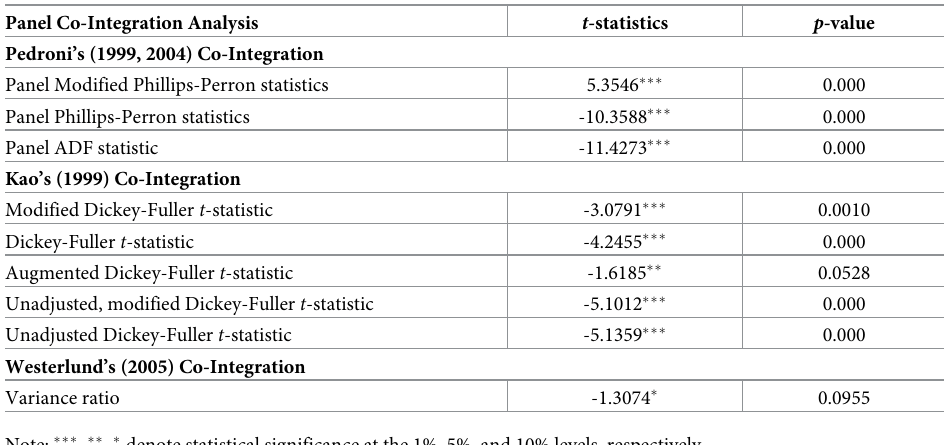
Table 4. Panel co-integration